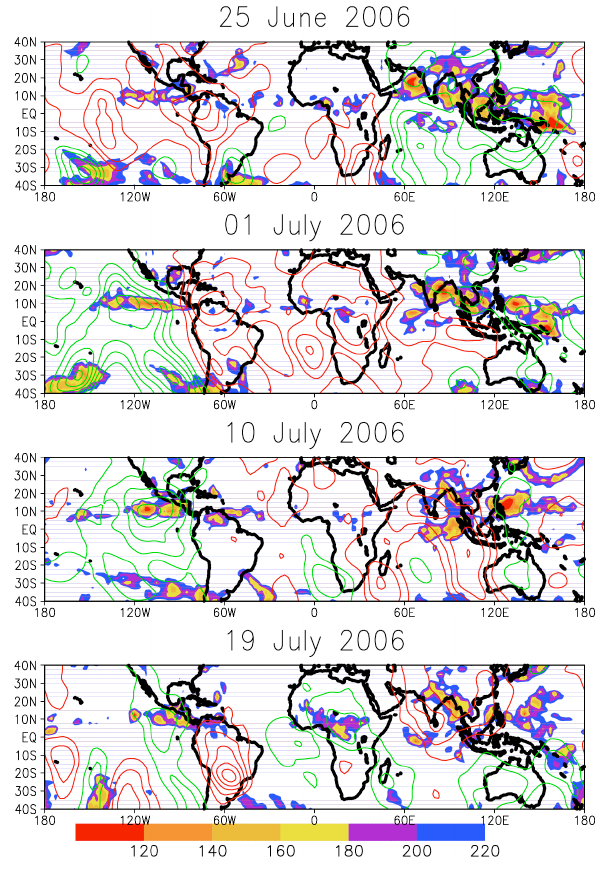
Figure 15. Daily OLR values (shaded) and 200 hPa NCEP velocity potential anomalies Fig. 15. Daily OLR values (shaded) and 200hPa NCEP velocity (relative the period 1979-1999) on 25 th June, 1 st July, 10 th and 19 th July 2006. Green (red) potential anomalies (relative the period 1979–1999) on 25 June, 1 contours means upper-level large-scale divergence (convergence), by step of 2 x 10 6 m 2 .s -2 July, 10 and 19 July 2006. Green (red) contours means upper-level (the zero isolines are not displayed). large-scale divergence (convergence), by step of 2 × 10 6 m 2 s − 2 (the zero isolines are not displayed).